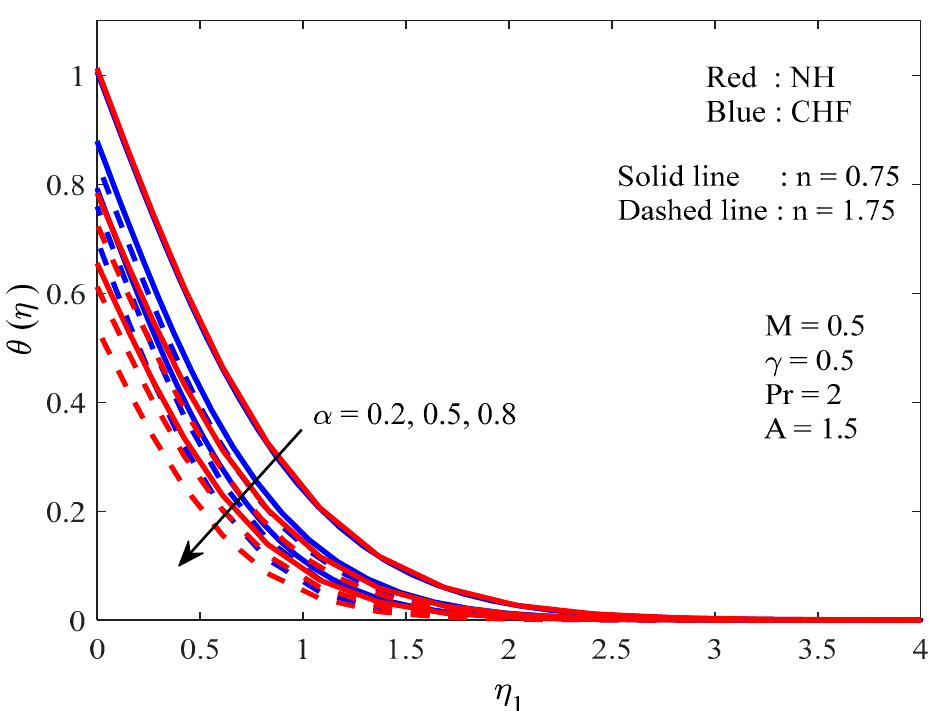
α . Figure 5. The temperature distribution profile with the influence of α α .